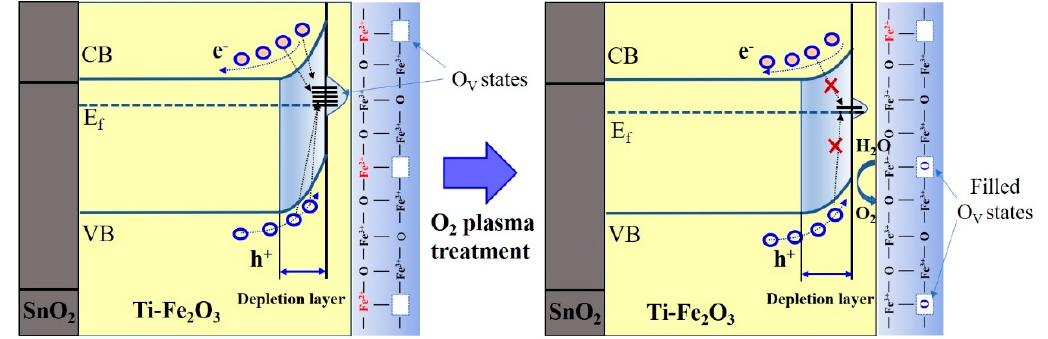
Scheme 1. Schematic illustration of the effect of O 2 plasma treatment on the surface oxygen vacancies of Ti-doped Fe 2 O 3 . (O V denotes the surface oxygen vacancies of Ti-doped Fe 2 O 3 ).